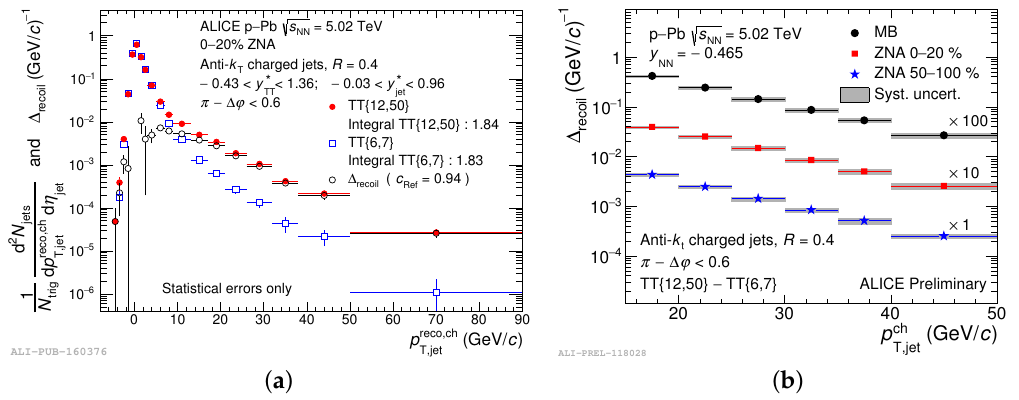
Figure 3. ( a ) Per trigger normalized transverse momentum spectra of recoil jets associated with trigger track p T bins TT{6,7} and TT{12,50} measured in the 0–20% neutron zero degree calorimeter √ s NN = 5.02TeV. ( b ) Fully corrected ∆ recoil distributions for (ZNA) centrality bin of p–Pb collisions at track-based anti- k T jets with R = 0.4. Systematic uncertainties in the data are shown by boxes. Taken from